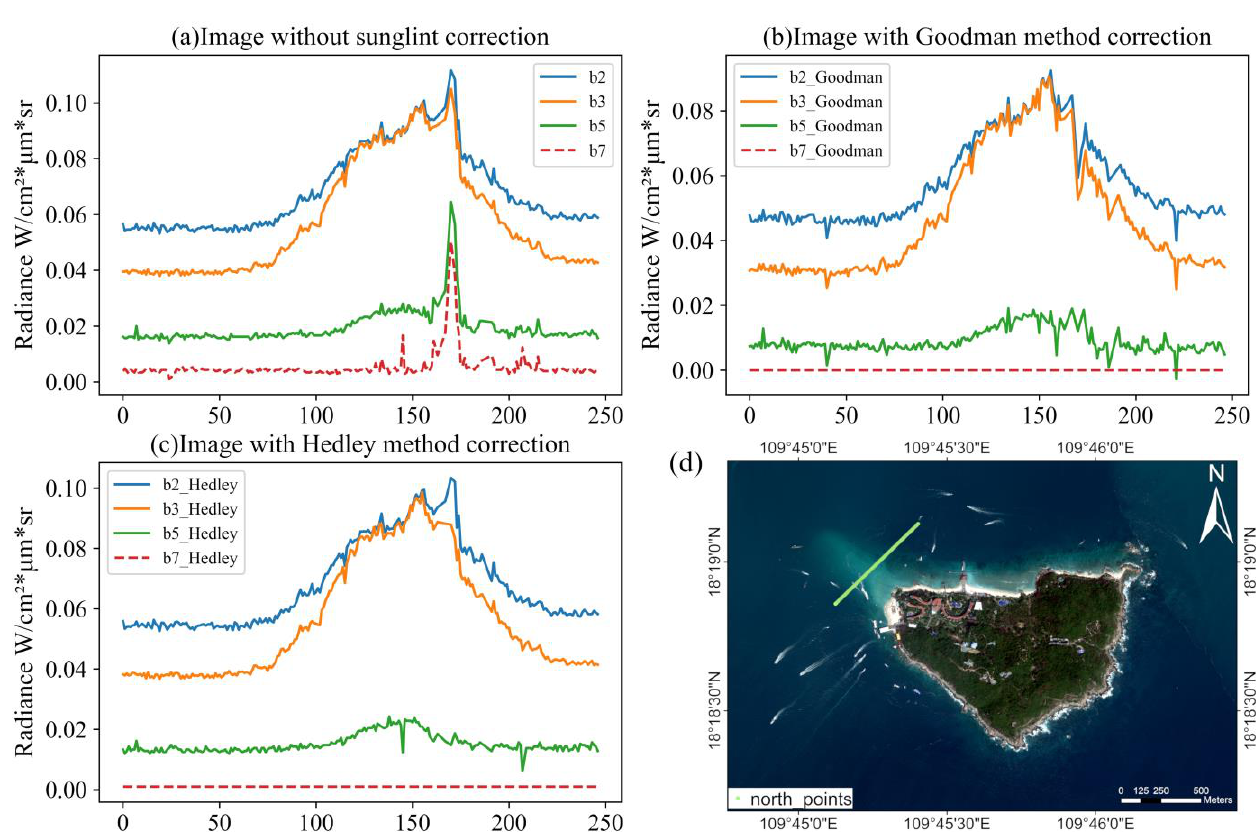
Figure 4. Images corrected by sun glint correction ( a , b ) and compared with uncorrected ones ( c ). Panel ( d ) shows the unprocessed true color image, and the pixels are obtained along the line from southwest to northeast.